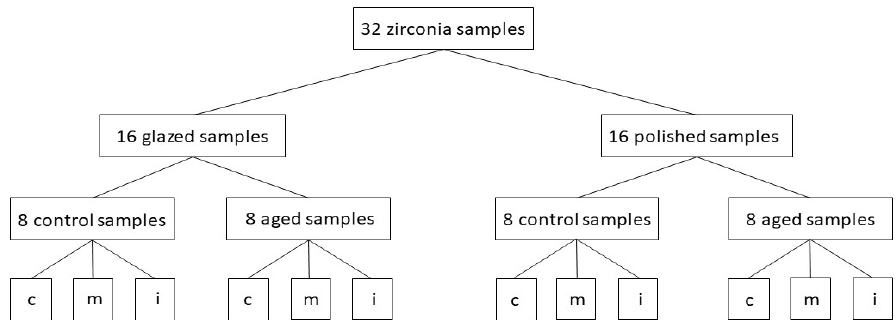
Figure 1. The flowchart of the study in which the main samples and groups were plotted and the way they are divided; c = cervical area, m = medium area, i = incisal area.